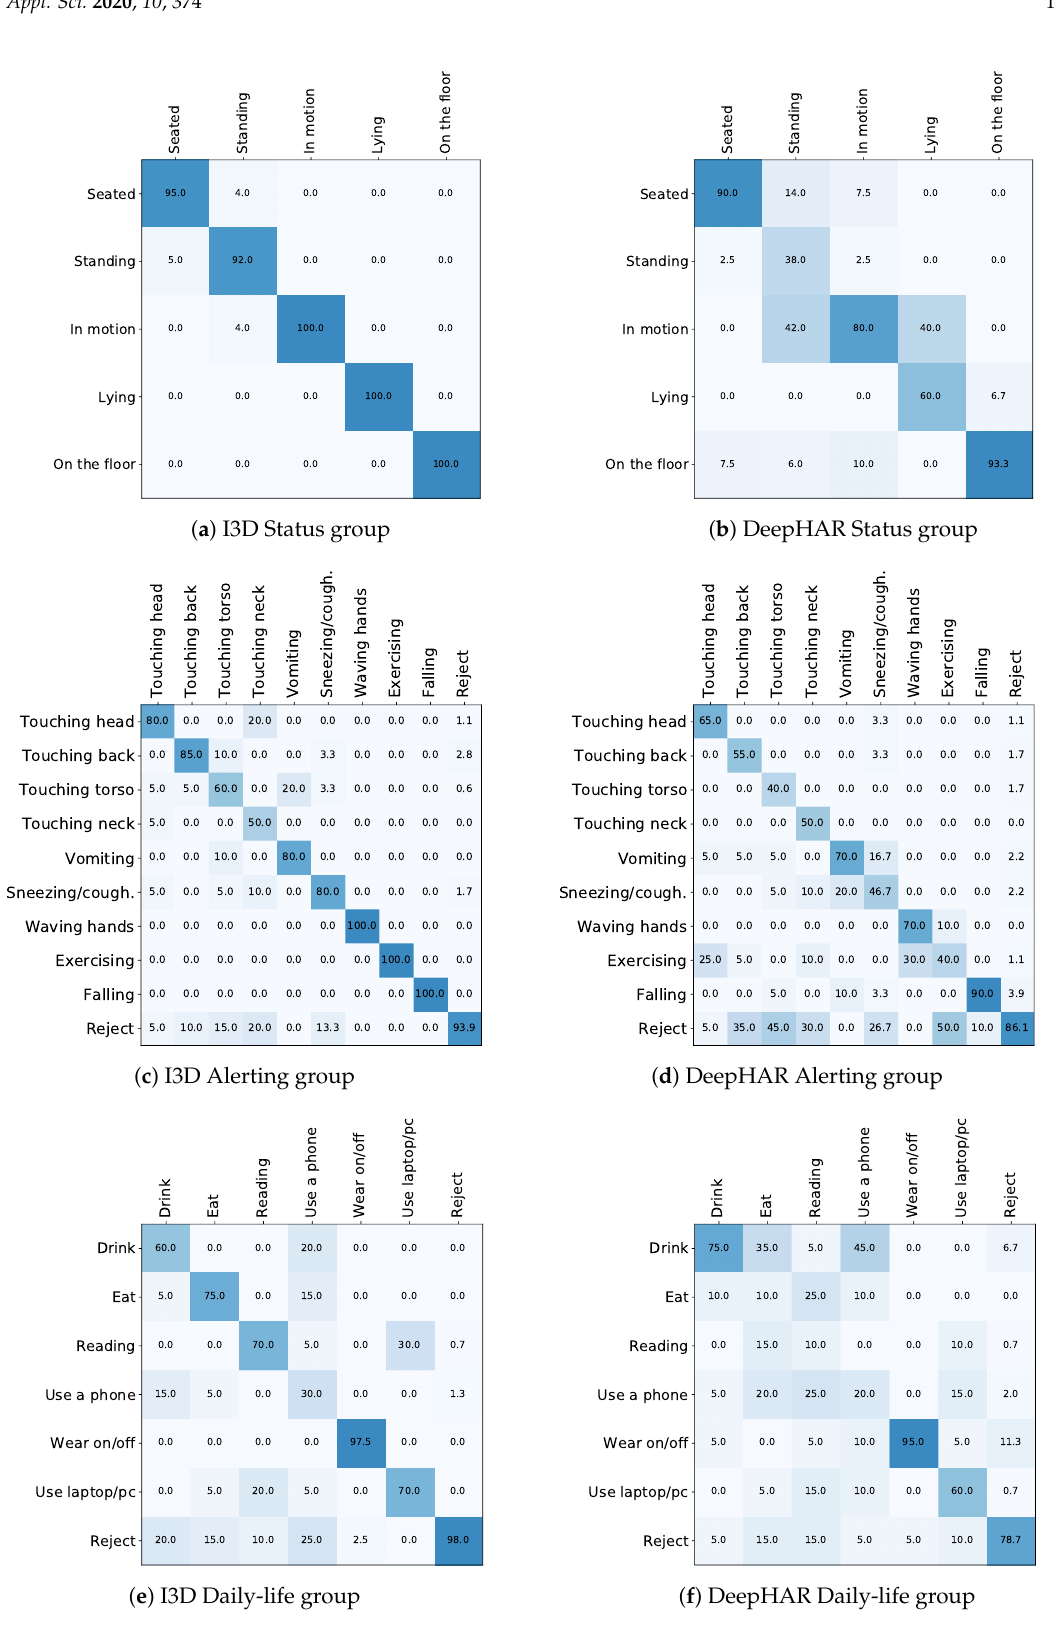
Figure 6. Action classification confusion matrix for each defined actions group. Left column refers to I3D, right to DeepHAR. Results refer to experiments with the people